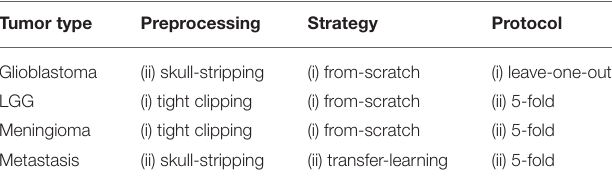
TABLE 2 | Summary of the model training strategy followed for each tumor type. Tumor